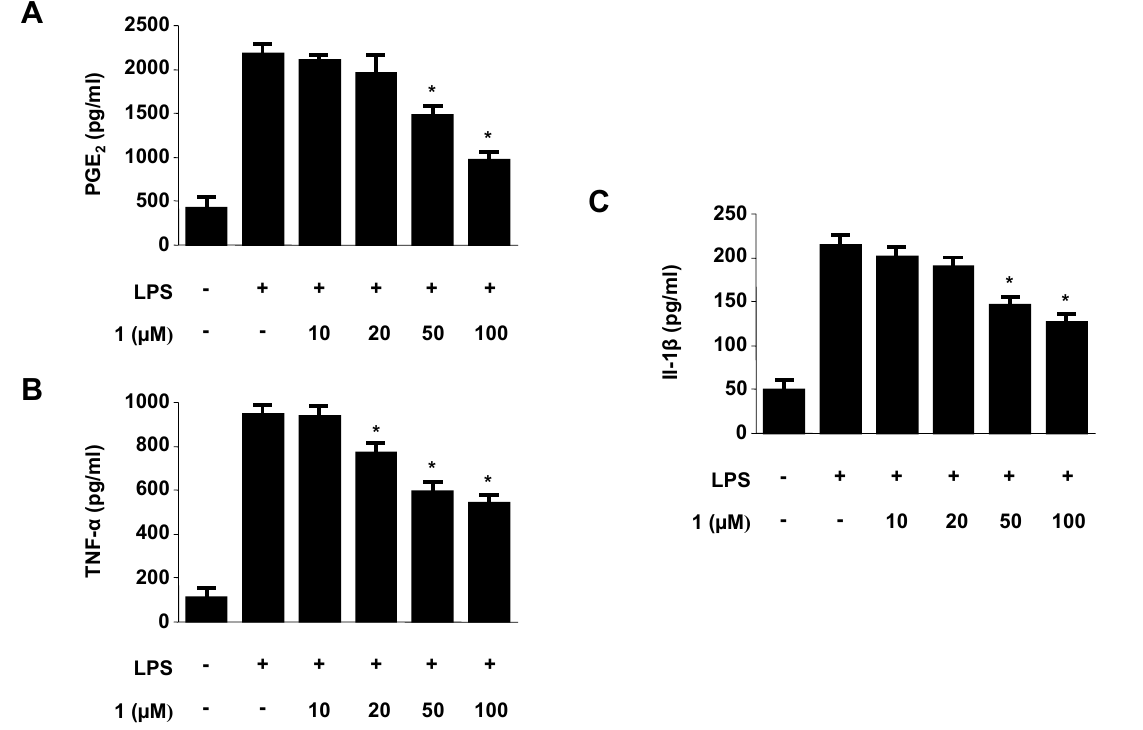
Figure 3. Effect of neoechinulin A ( 1 ) on the production of PGE (A) TNF- α (B), and 2 IL-1 β (C). RAW264.7 macrophages were pre-treated with the indicated concentrations of neoechinulin A for 3 h, and then stimulated with LPS (1 μ g/mL) for 18 h. The concentrations of PGE (A) TNF- α (B), and IL-1 β (C) were determined as described in the 2 Experimental. Data shown represent the mean values of three experiments ± SD. * p < 0.05 as compared to the group treated with LPS